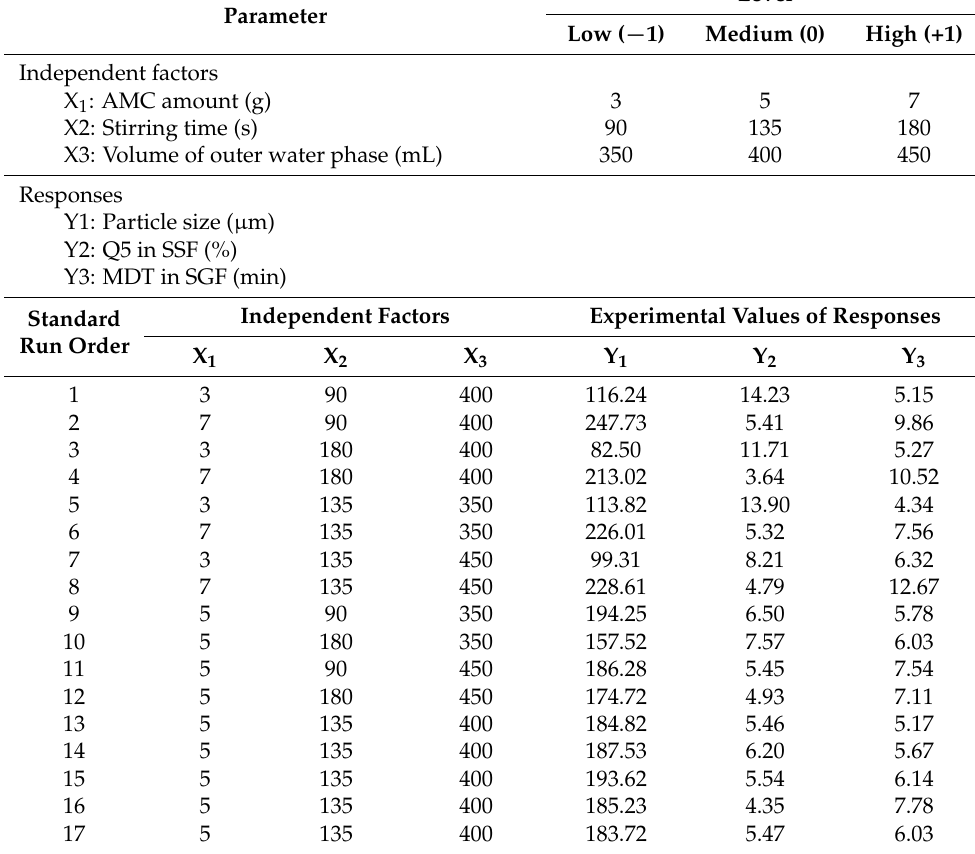
Table 3. Independent factors, level of each factor, and responses in the Box-Behnken design of DPH-loaded microparticles preparation. Parameter